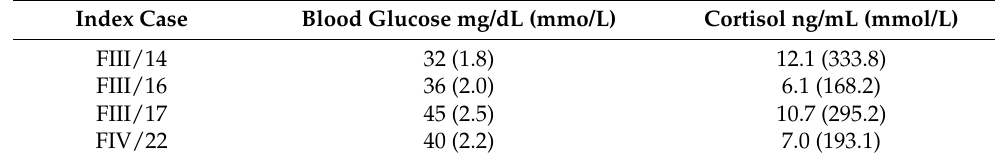
Table 4. Cortisol responses based on insulin tolerance test in patients from families III and IV after cessation of hydrocortisone.